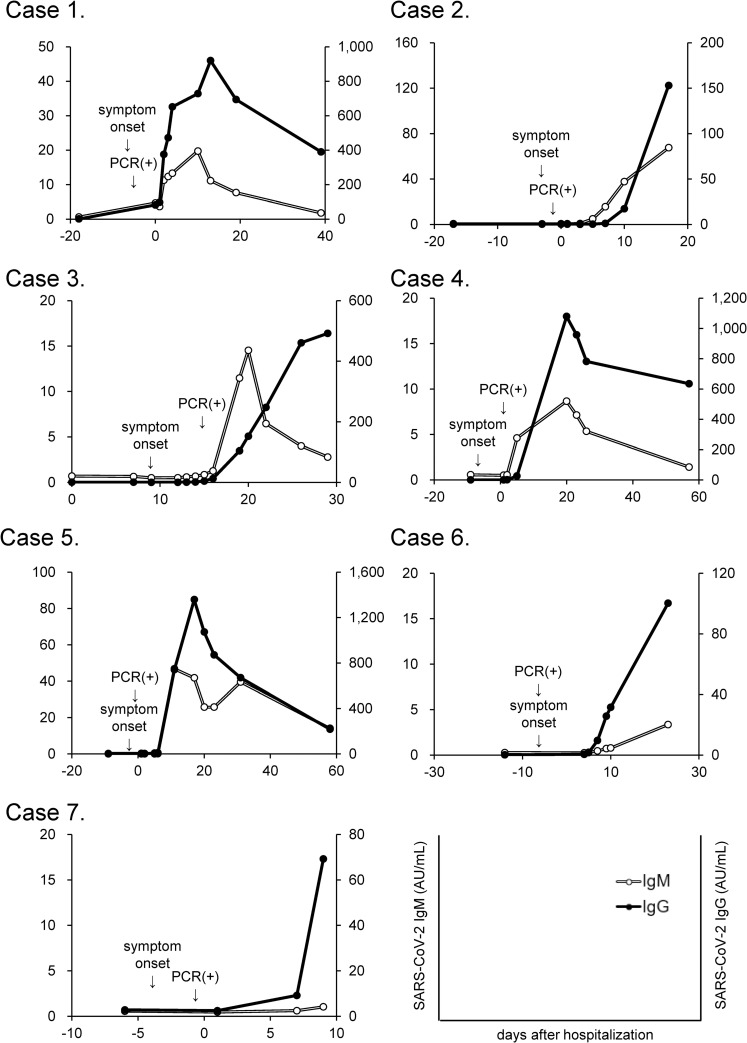
Time course of serum antibody titers in COVID-19 subjects.The time courses of the SARS-CoV-2 IgM and SARS-CoV-2 IgG titers in sera collected before and after the onset of COVID-19 were examined in seven patients.